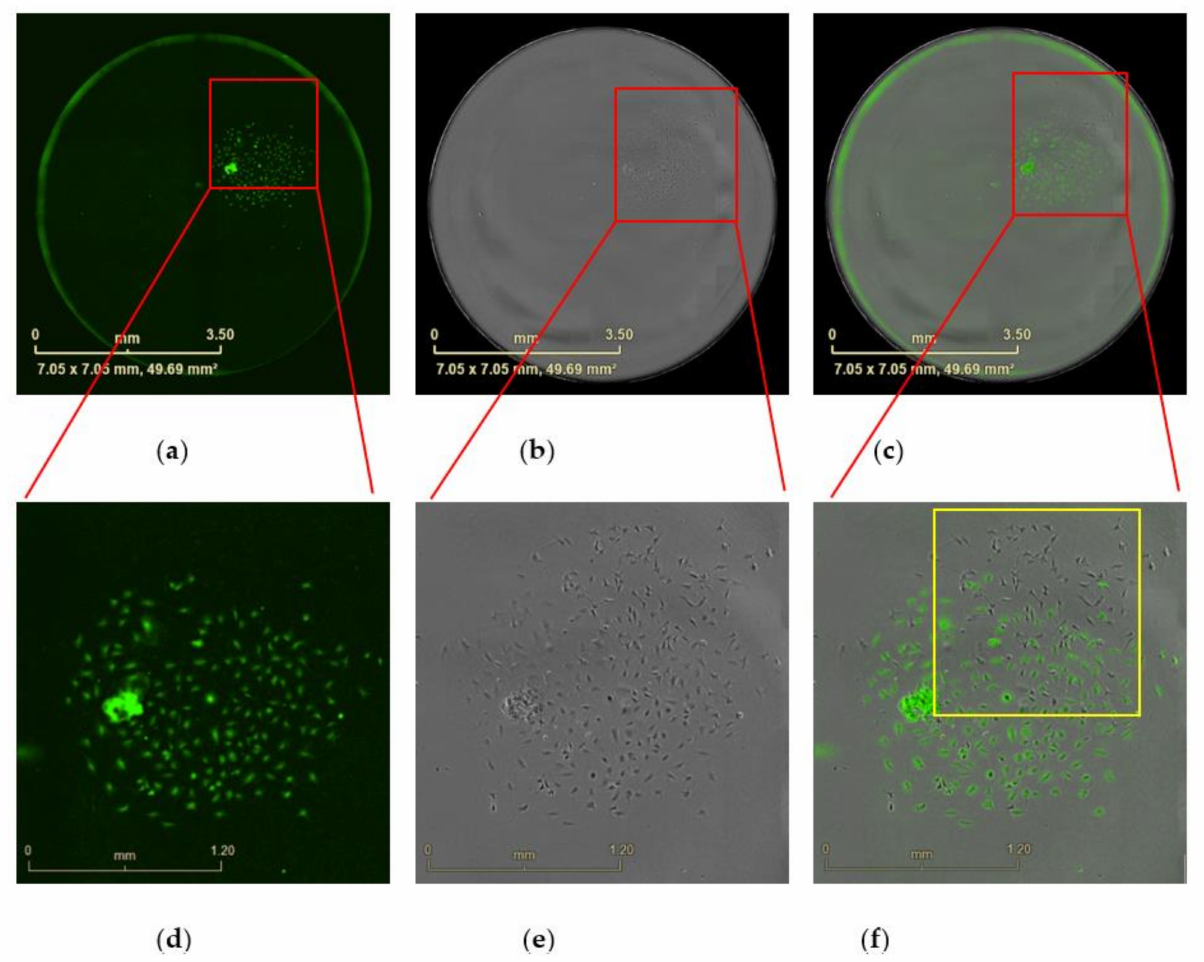
Figure 8. Wells with polyclonal cells in close proximity or mixed with each other. Images from 96-well plate scanned after